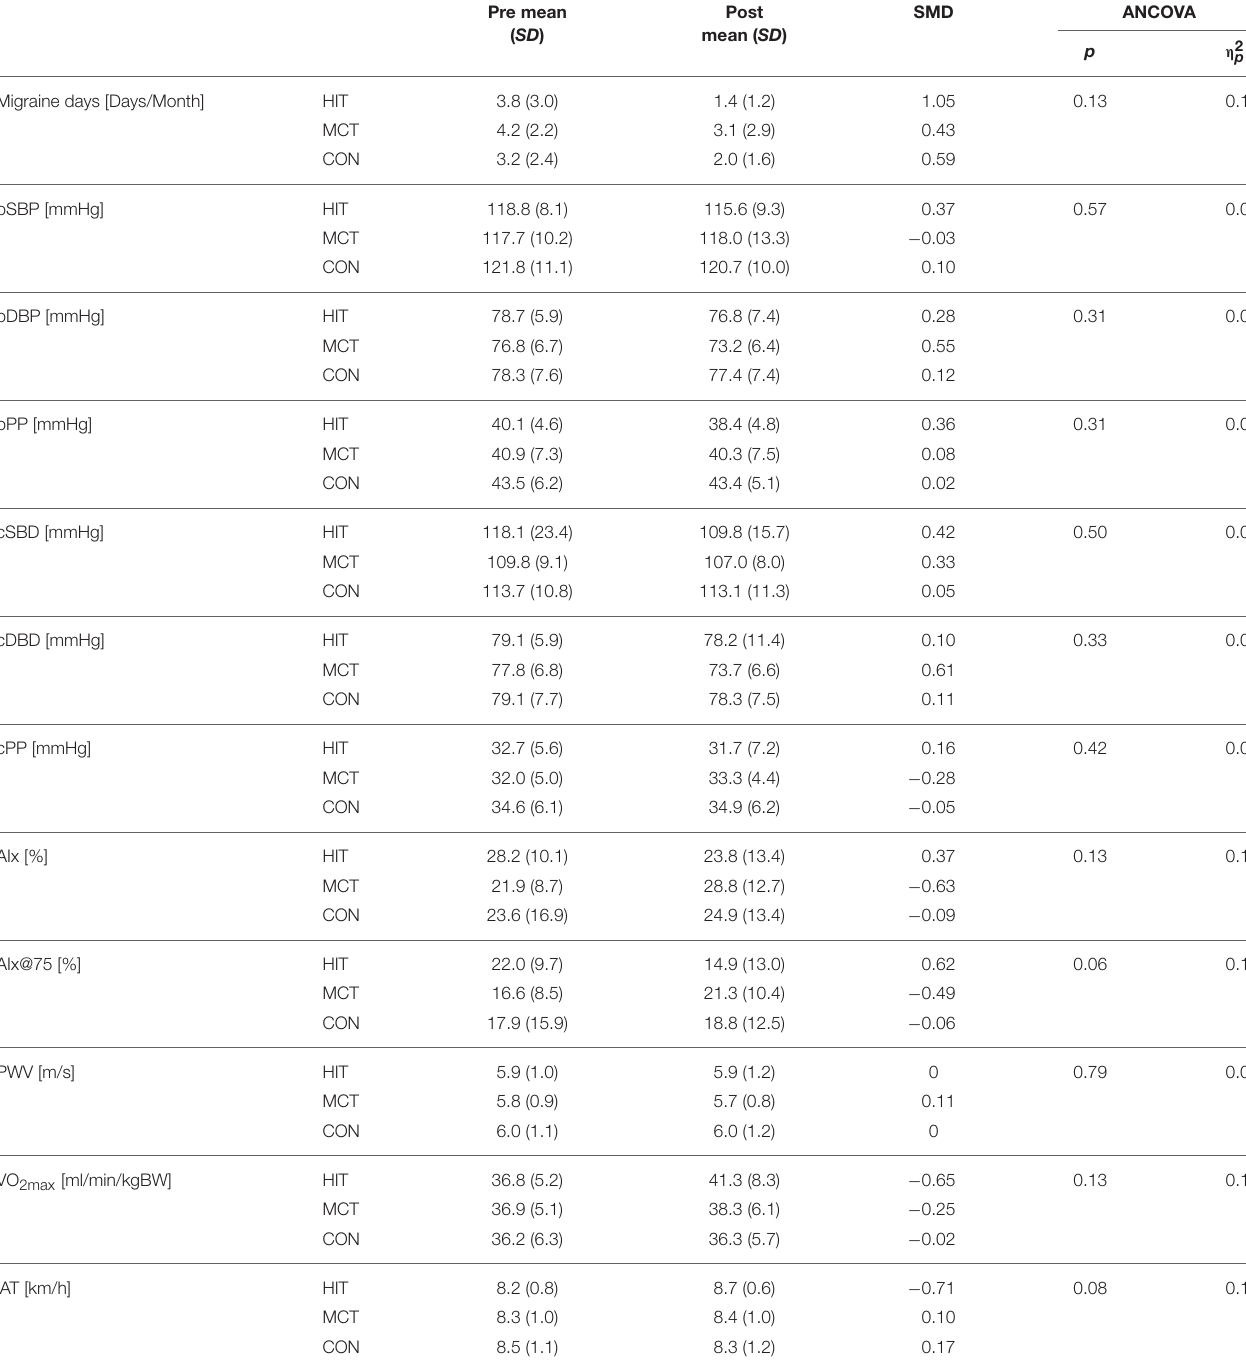
TABLE 2 | Pre and post intervention results of all three groups for peripheral and central vessel parameters and arterial stiffness